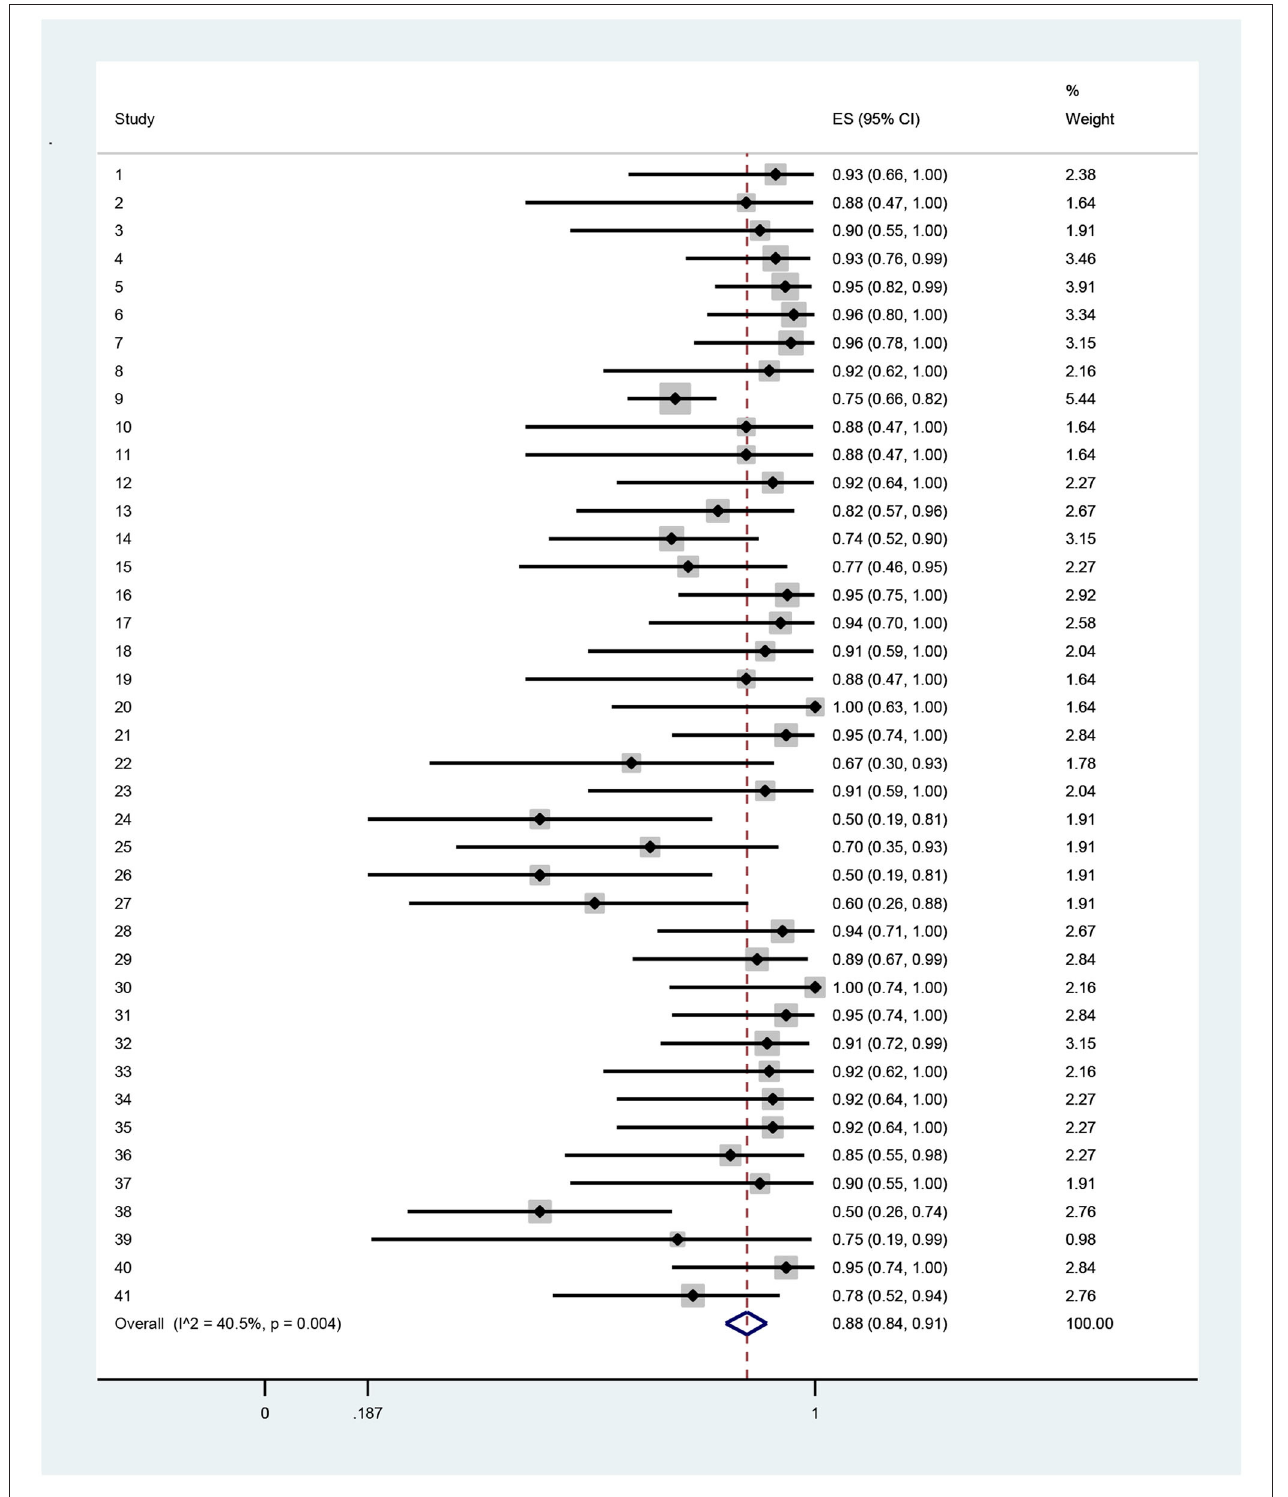
FIGURE 4 | Forest plot of estimates and 95% confidence intervals of the economics of scale efficiency among Iranian hospitals.